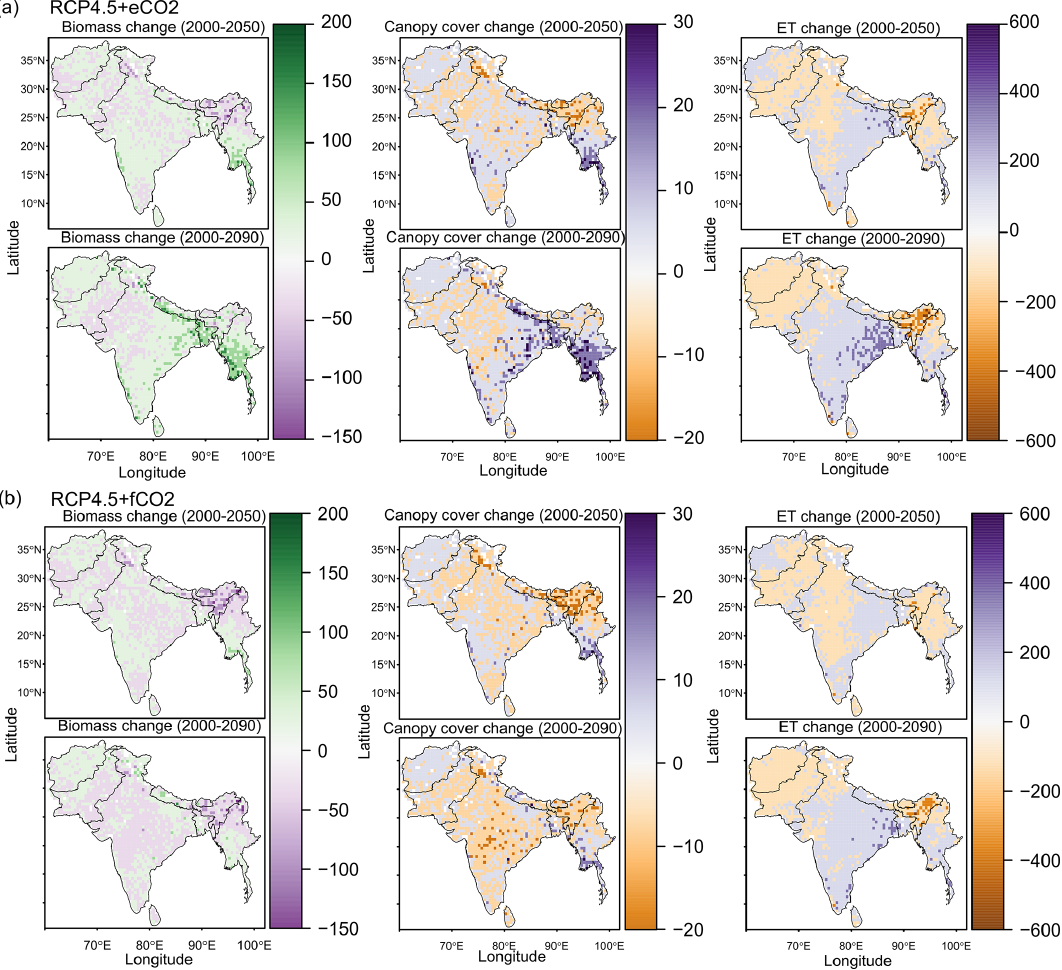
Figure 4. Projected change in biomass (t/ha), canopy cover (%) and evapotranspiration (ET, mm/year) between the 2000s and 2050s and between the 2000s and the 2090s under (a) RCP4.5 + e CO 2 and (b) RCP4.5 + f CO 2 . See Fig. S7 for projected change of these variables under RCP8.5.